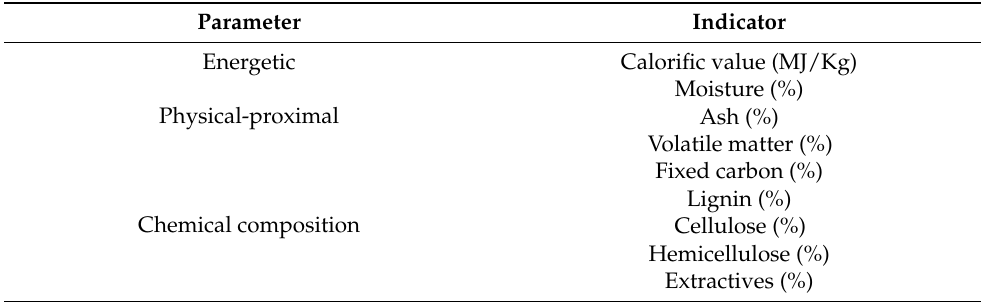
Table 4. Parameters and indicators used in the multi-criteria analysis.